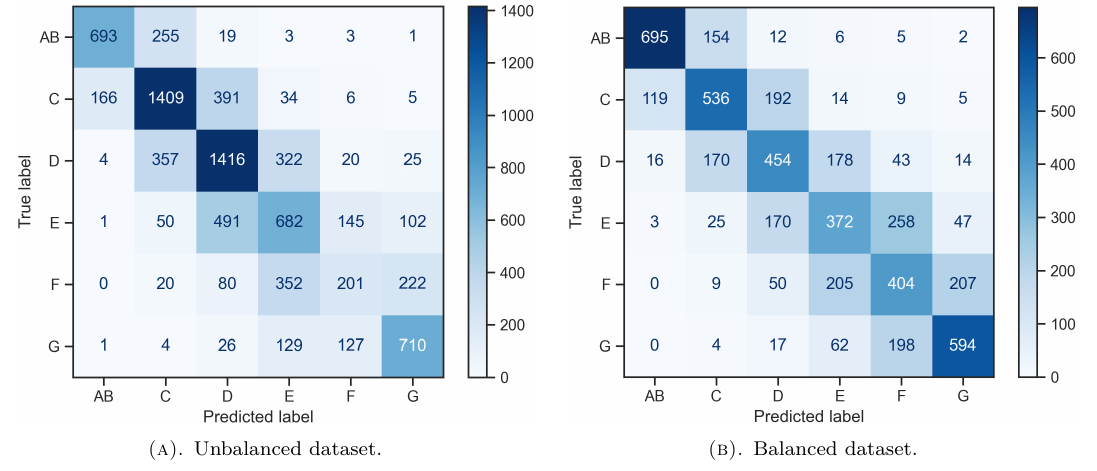
Figure 3. Confusion matrices for global efficiency.